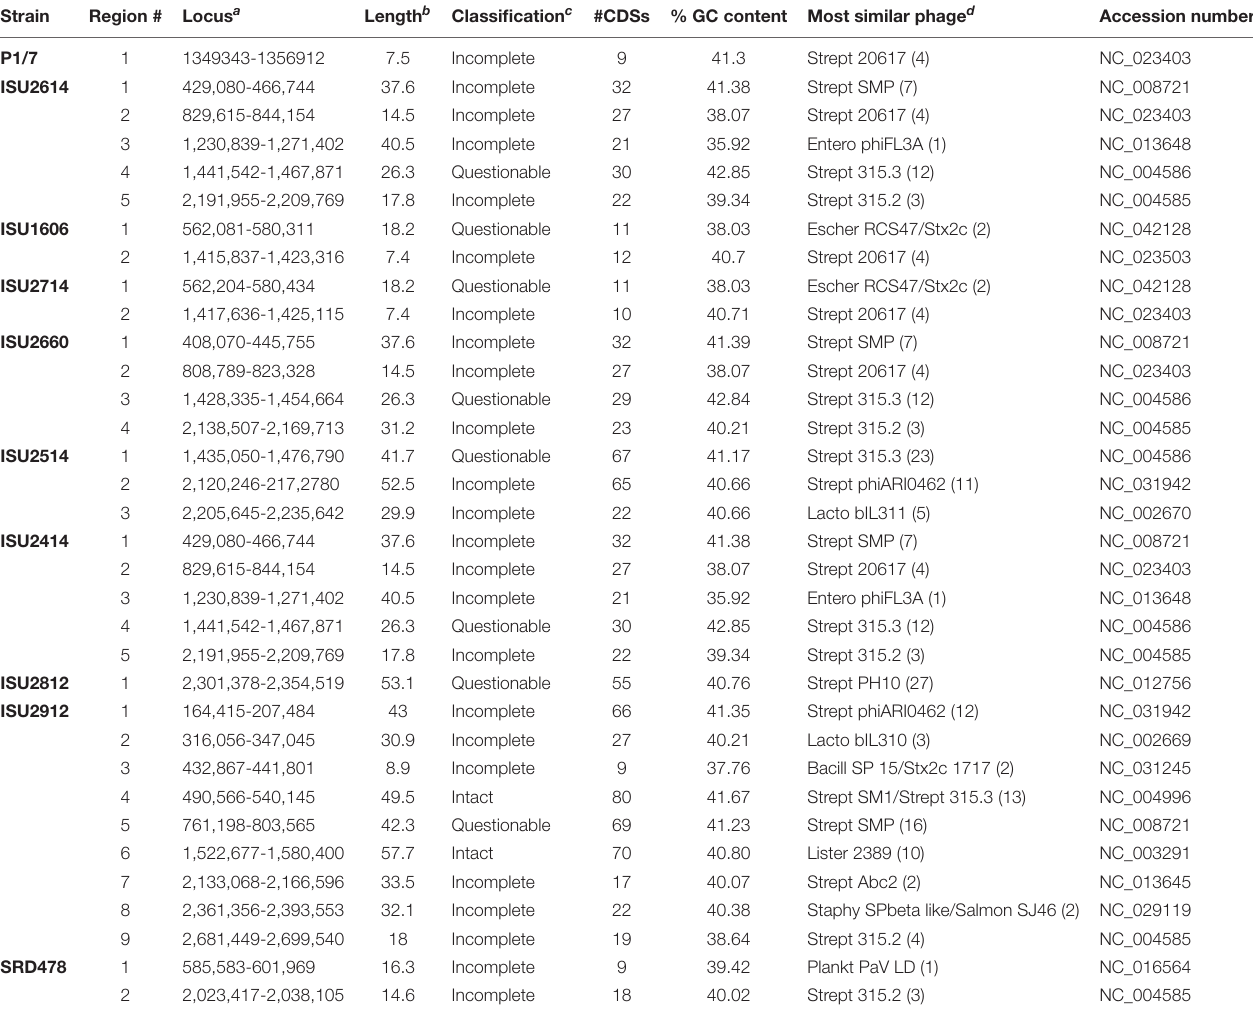
TABLE 5 | Prophage regions identified in S. suis genome sequences. Strain Region # Locus